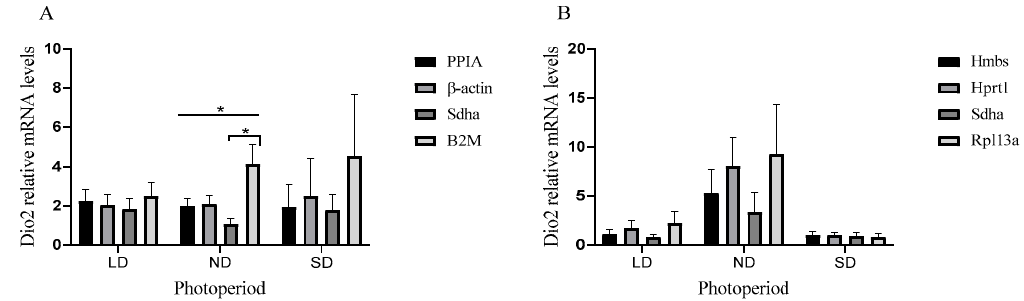
Figure 1. Identification of the stability of reference gene expression. Expression levels of a target gene, Dio2 , in hypothalamus tissues at the developmental stage of PND 12w (A) and 24w (B) were normalized by using the top two most stable and least stable candidates under individual developmental stages. Bars represent the means and SEM. p < 0.05, *.